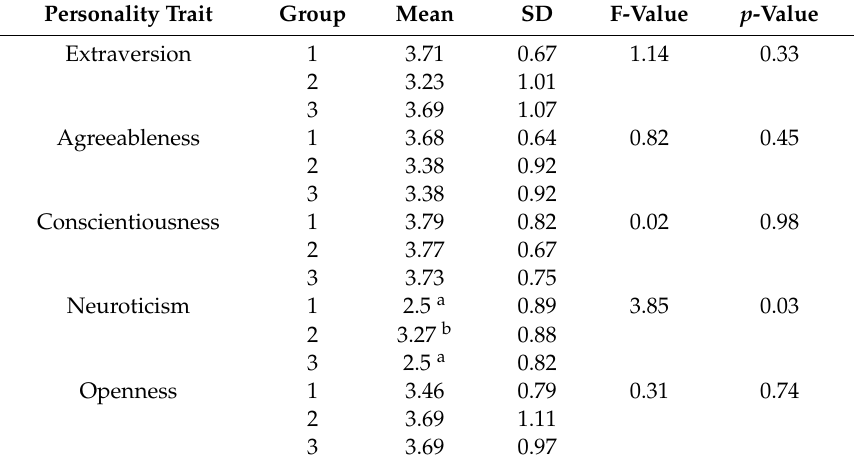
Table 2. Di ff erences between groups (Group 1 = non-aggressive dogs; Group 2 = dogs, aggressive towards humans; Group 3 = dogs, aggressive towards animals) in owners’ personality traits. Bold—statistically significant result. Means with di ff erent superscript letters di ff er